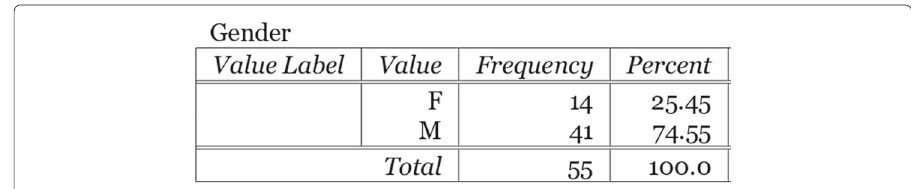
Fig. 10 Gender distribution in the sampled students from morning groups